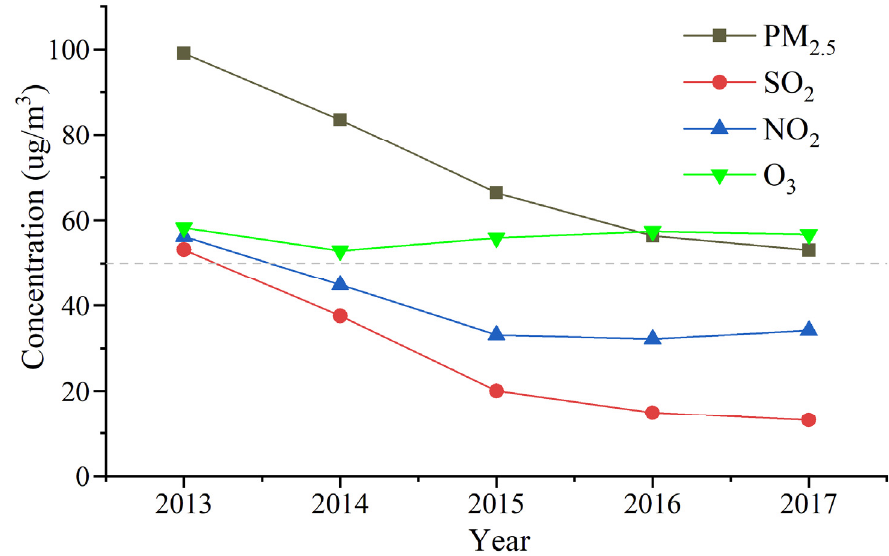
Figure 13. Annual variations of ground ‐ level PM 2.5 , SO 2 , NO 2 , and O 3 observed by ambient monitoring stations located in Hubei during 2013–2017.